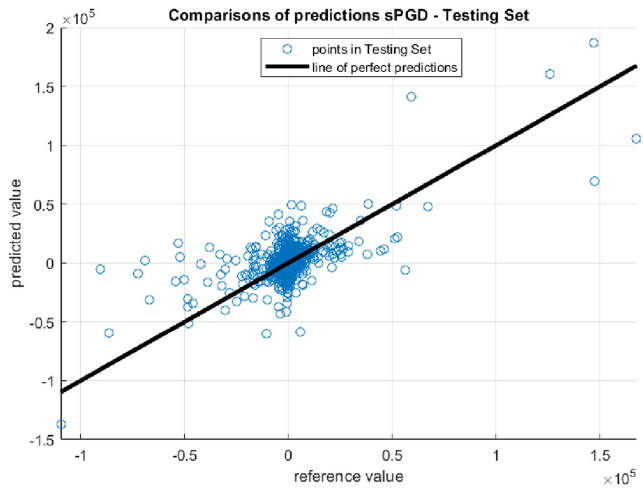
Fig. 10 Problem defined in Eq. 4.5: Comparison of predicted s -PGD values with the reference ones in the testing set (the black line represents a perfect prediction)